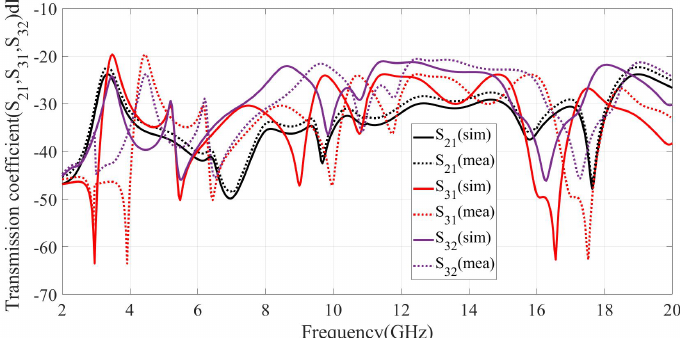
Figure 9. Transmission coefficient of antenna (S 21 , S 31 , and S 23 ) vs.